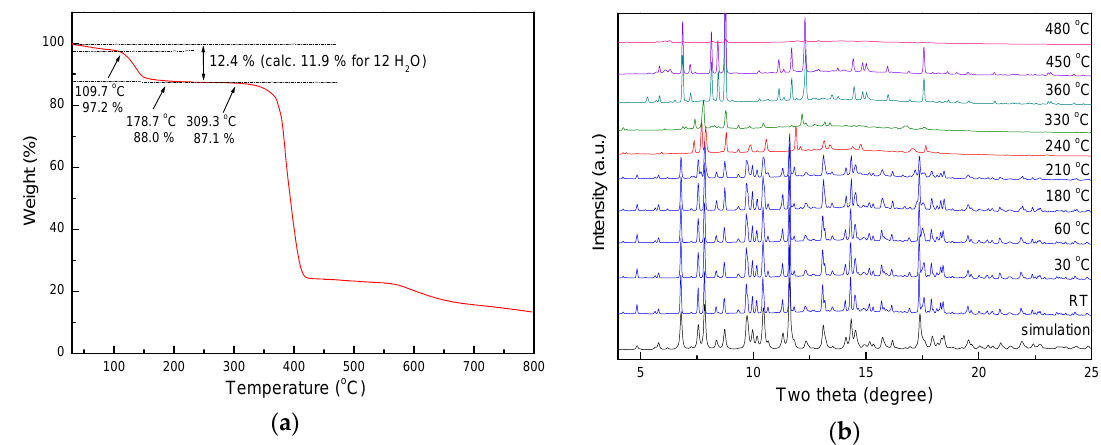
Figure 3. ( a ) Thermogravimetric (TG) analysis of 1 ; ( b ) In-situ PXRD patterns of 1 at different temperatures, and simulated PXRD pattern from single-crystal X-ray diffraction data.